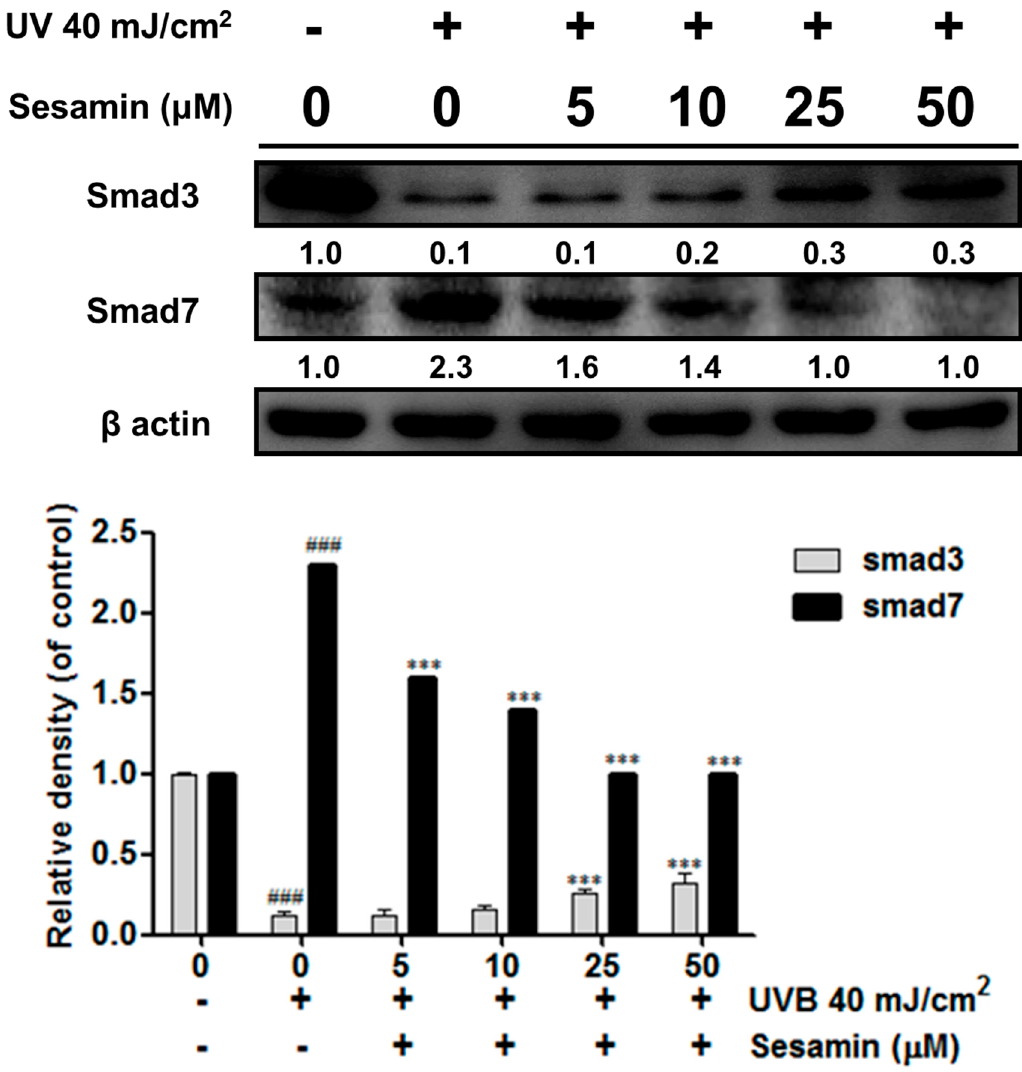
Figure 7. Sesamin modulated the UVB-mediated Smad 3 and Smad 7 expression in human skin fibroblasts. ### p < 0.001: Significant di ff erence versus non-irradiation group. *** p < 0.001: Significant di ff erence versus non-treatment group.